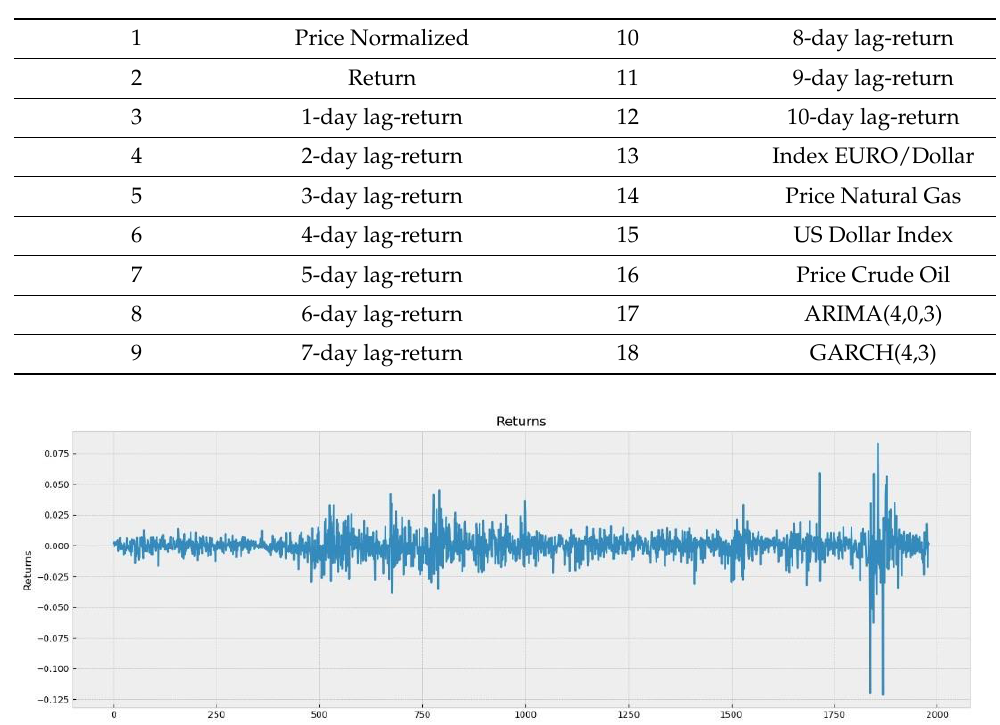
Table 4. Selected features as the inputs of the models.